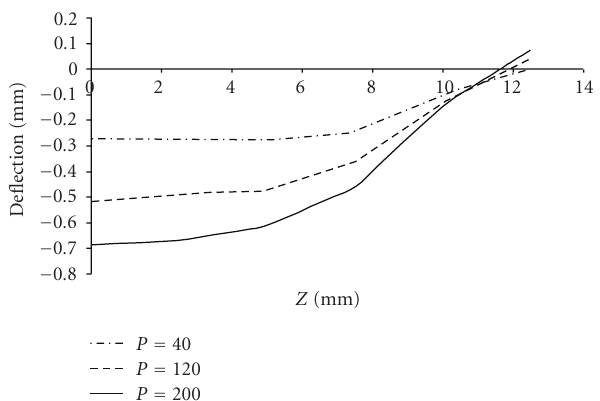
Figure 6: Deflection profile in the lateral direction across narrowest opening (see Figure 2(c)).